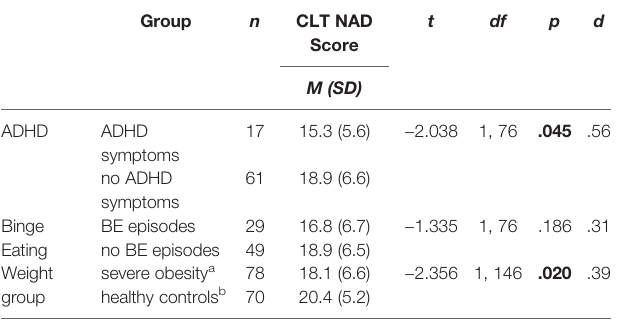
TABLE 3 | Discriminant validity of the Cards and Lottery Task regarding different clinical groups.